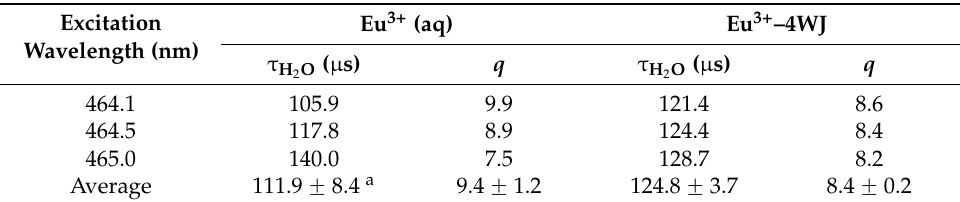
Table 2. Eu 3+ lifetime data and estimate of coordinating water